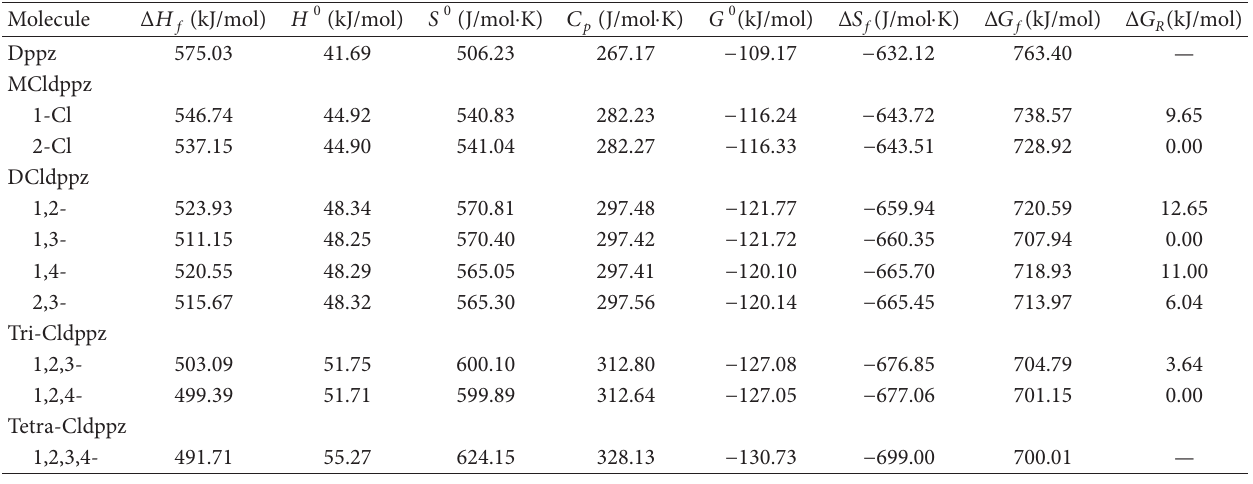
T 4: ermodynamic parameters by PM6 calculations.